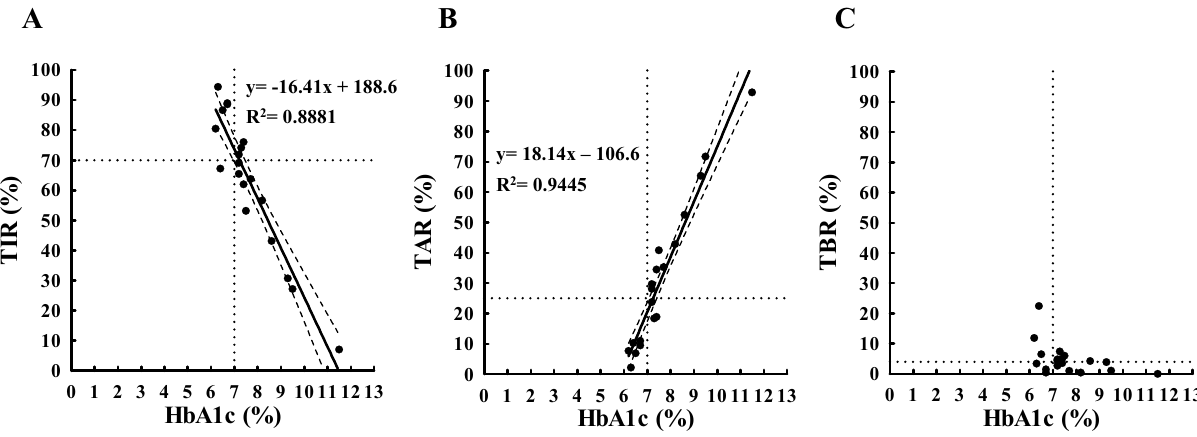
Figure 1. Scatterplot indicating the relationship between HbA1c (x-axis) and CGM-related metrics (TIR ( A ), TAR ( B ), and TBR ( C ); y-axis) measured within 120 days from baseline. The solid line is the line of best-fit from the linear regression analysis. The dashed band is the 95% confidence band of the best-fit line. The dotted horizontal lines represent a TIR of 70% ( A ), a TAR of 25% ( B ), and a TBR of 4% ( C ): these values are based on the targets of TIR, TAR, and TBR for adults with type 1 or type 2 diabetes from recommendations of the ATTD 2019 consensus statement. The dotted vertical lines represent an HbA1c of 7%. TIR time in range (glucose 70–180 mg/dL), TAR time above range (glucose ≥ 181 mg/dL), TBR time below range (glucose ≤ 69 mg/dL), R 2 coefficient of